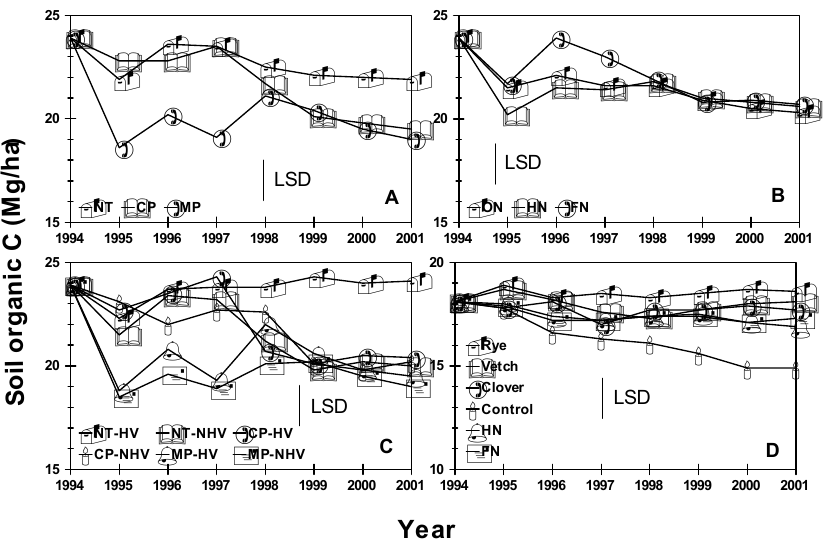
FIGURE 2 . Soil organic C concentration as influenced by tillage, cover crops, and N fertilization rates. (A, B, and C) NT denotes no- till; CP, chisel plowing; MP, moldboard plowing; HV, hairy vetch; NHV, no hairy vetch; ON, 0 kg N/ha; HN, 60–90 kg N/ha; and FN, 120–180 kg N/ha. (D) Vetch denotes hairy vetch; clover, crimson clover; control, no cover crop or N rate; HN, 80–90 kg N/ha; and FN, 160–180 kg N/ha. LSD denotes least significant difference at p < 0.05[22].